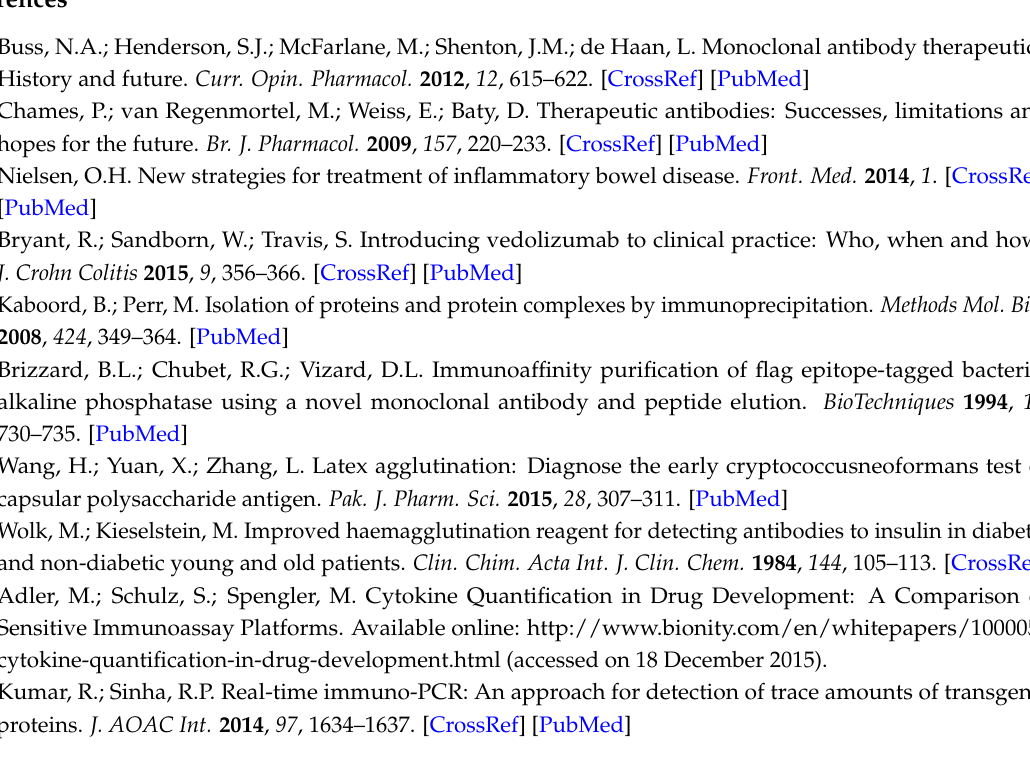
Table S1: Studies of the affinity of biolayer coating obtained using various preparation methods for different Abs concentrations. Table S2: Effects of different chaotropic agents on the number of measurement runs N (MU used for receptor layer coating). Table S3: Repeatability evaluation of net signal measurements for target samples vs. reference solution full data. Table S4: Intermediate precision evaluation of net signal measurements for target samples vs. reference solution ( n = 150, p = 0.95) full